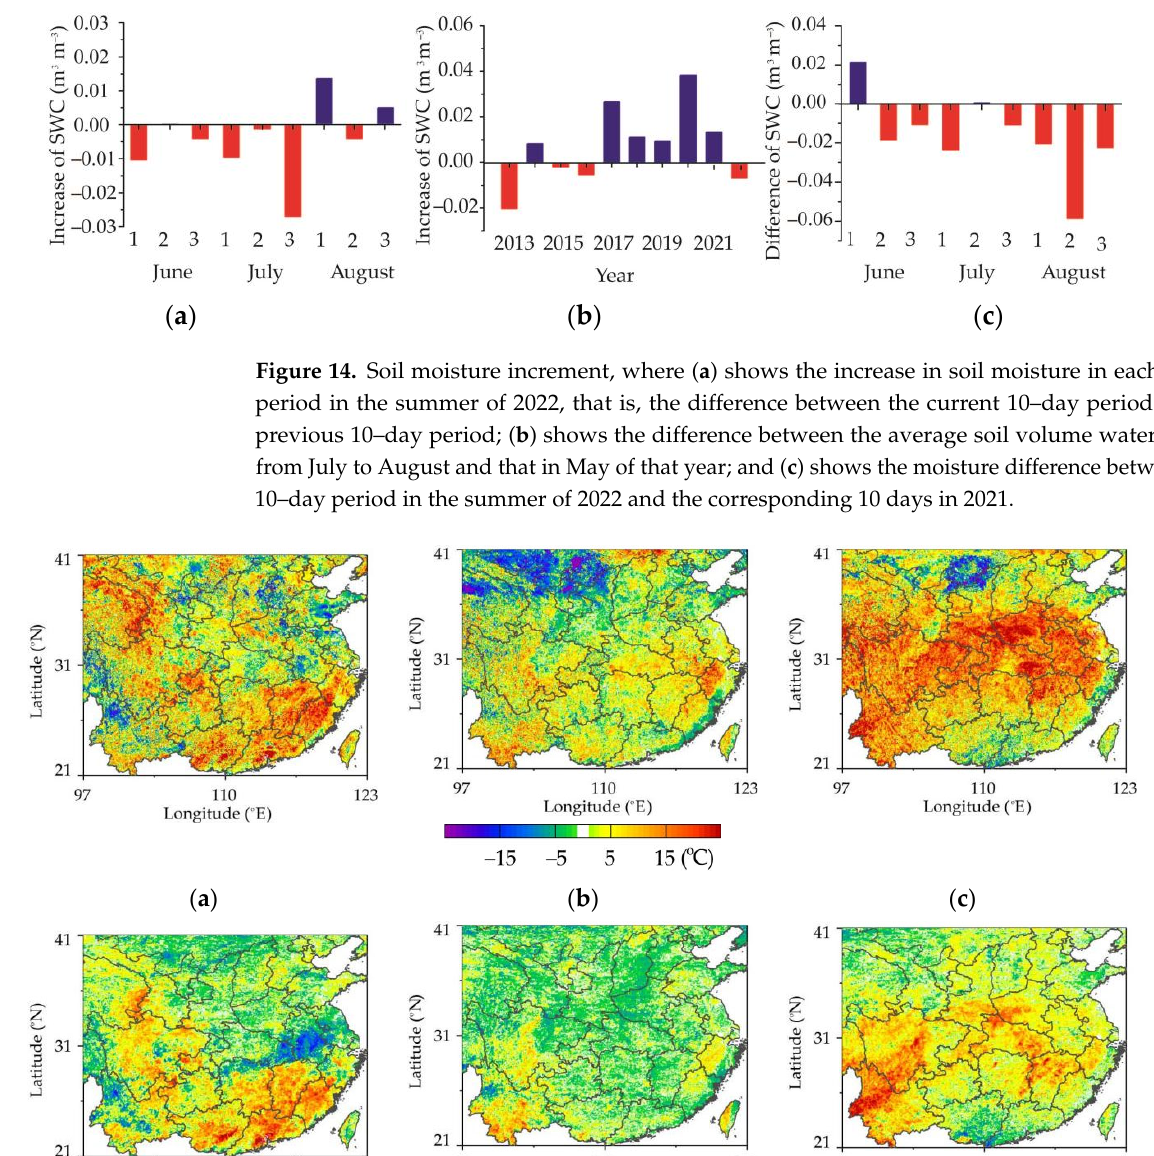
Figure 13. Distributions of LST and ET in the summer of 2022, where ( a – c ) are the distributions of LST in late June, late July, and middle August, respectively, and ( d – f ) are the distributions of ET in late June, late July, and middle August, respectively.